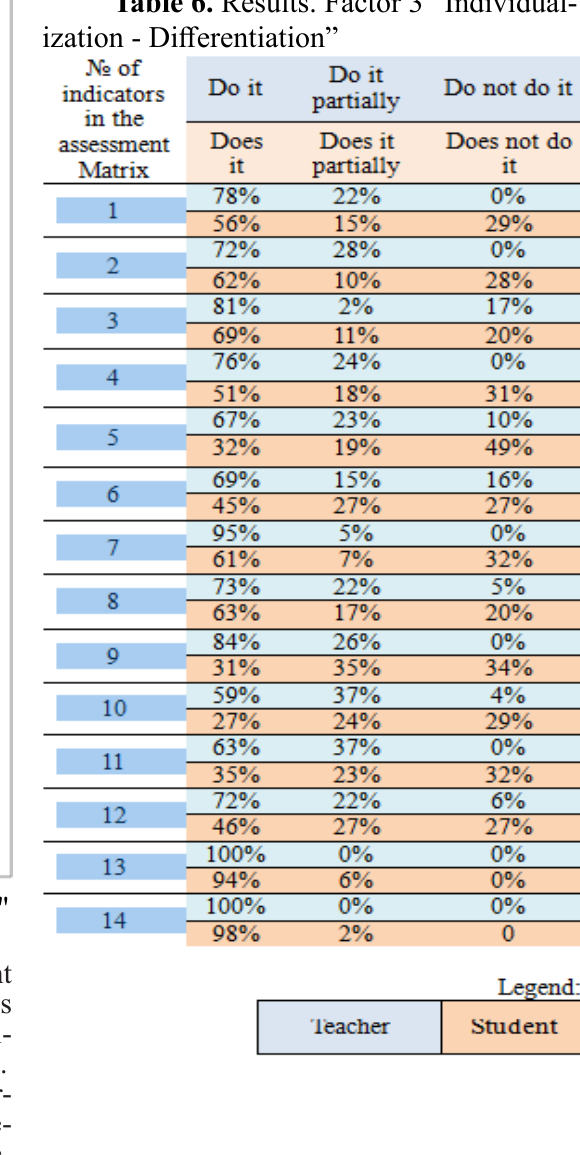
Table 6. Results. Factor 3 “Individual